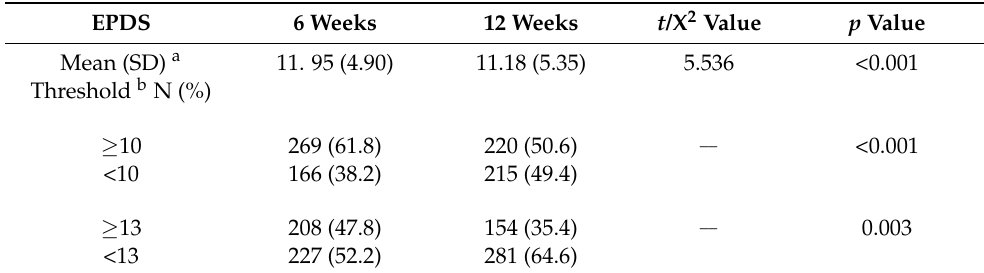
Table 6. Comparison of the mean EPDS scores and proportions with EPDS scores of 10 or above and 13 or above at 6 and 12 weeks postpartum ( n =